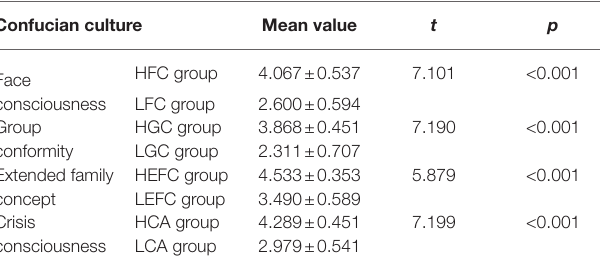
TABLE 3 | Confucian culture scores under the four